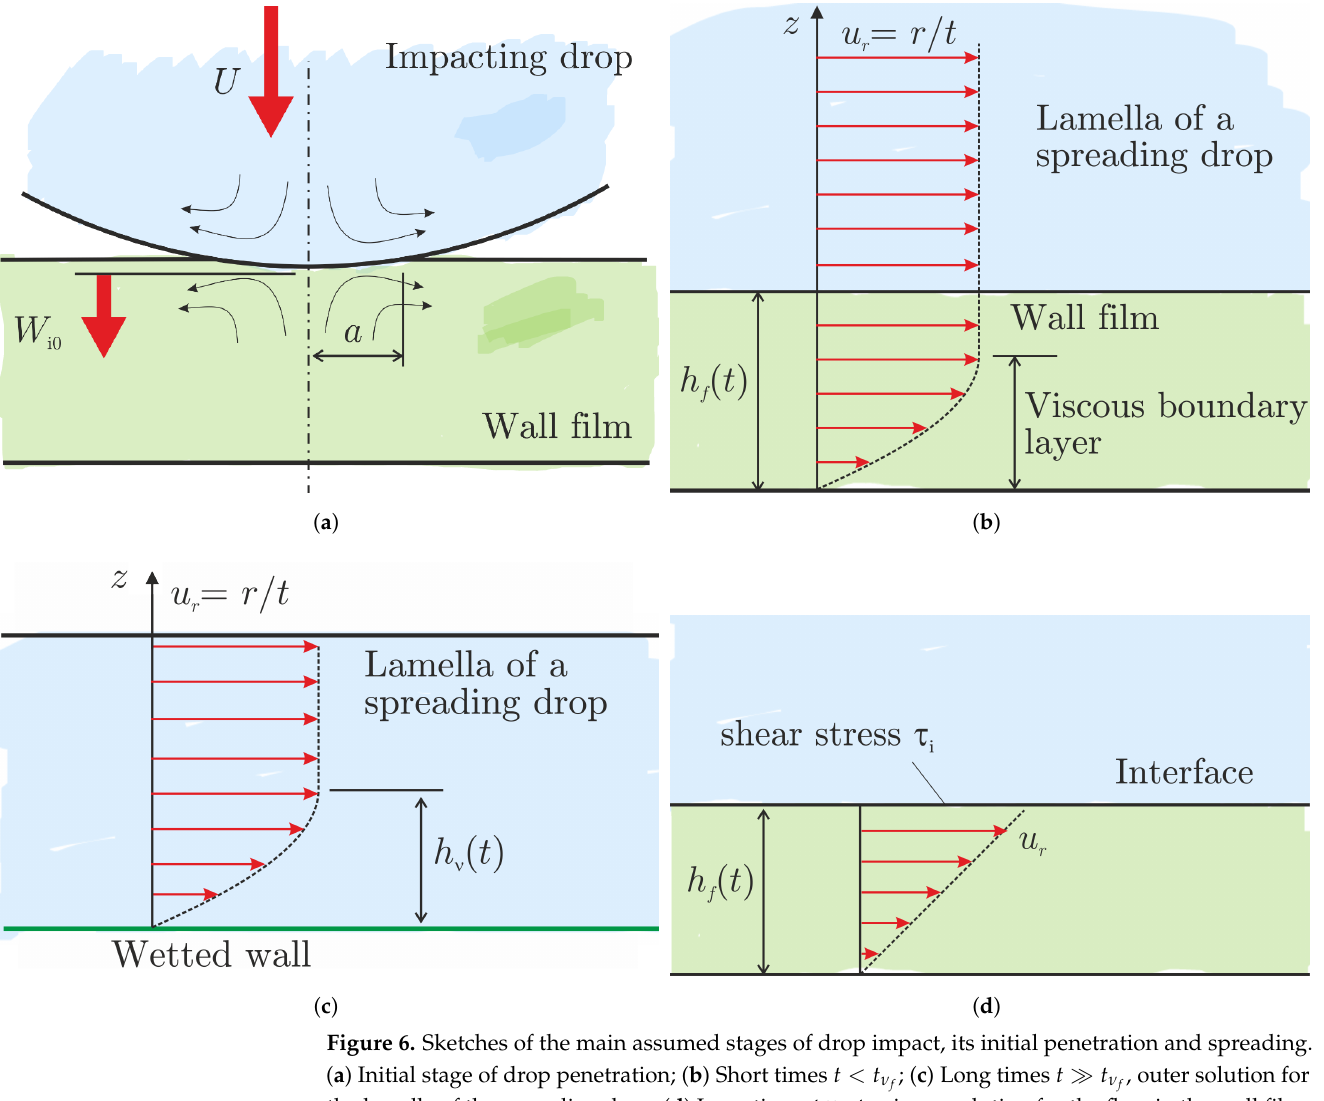
; ( c ) Long times t (cid:29) t ν , outer solution for f f , inner solution for the flow in the wall f